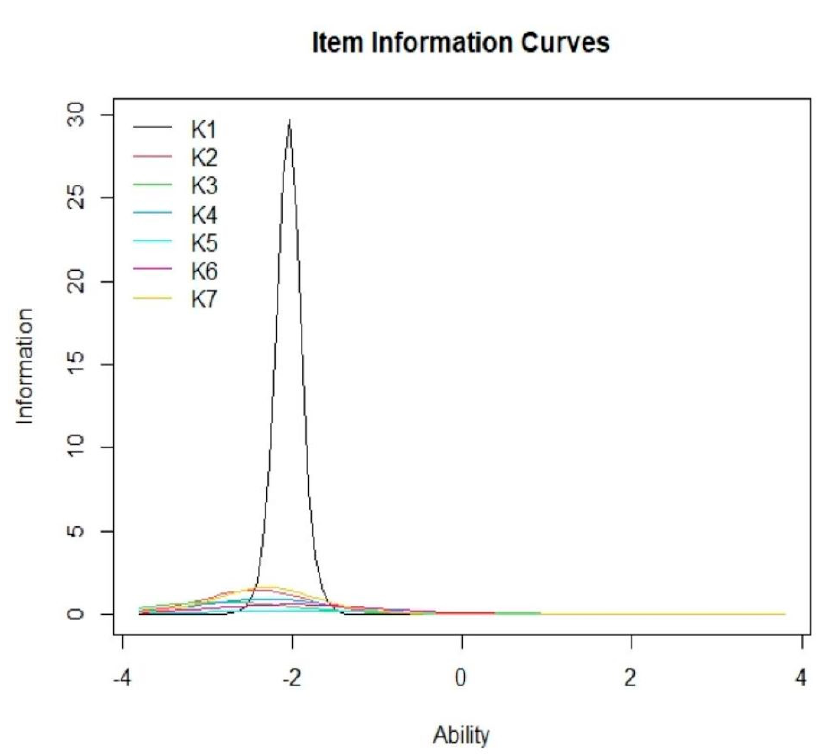
Figure 2. Item- information curves of the test.